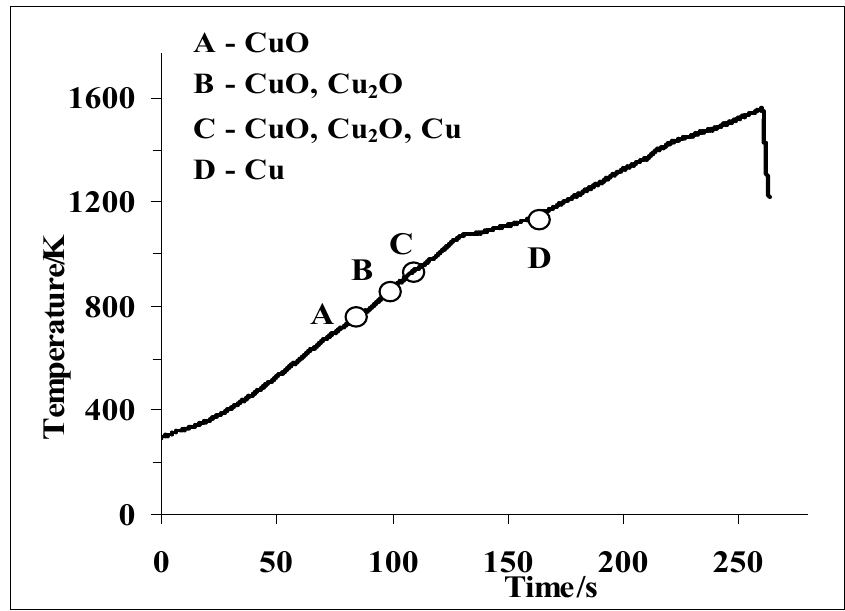
Figure 4. The heating thermogram of the CuO + C mixture with the XRD analysis results of the quenched samples at different characteristic temperatures, A—T = 773, B—873, C—973, D—1153 K, V h = 300 K min − 1 .